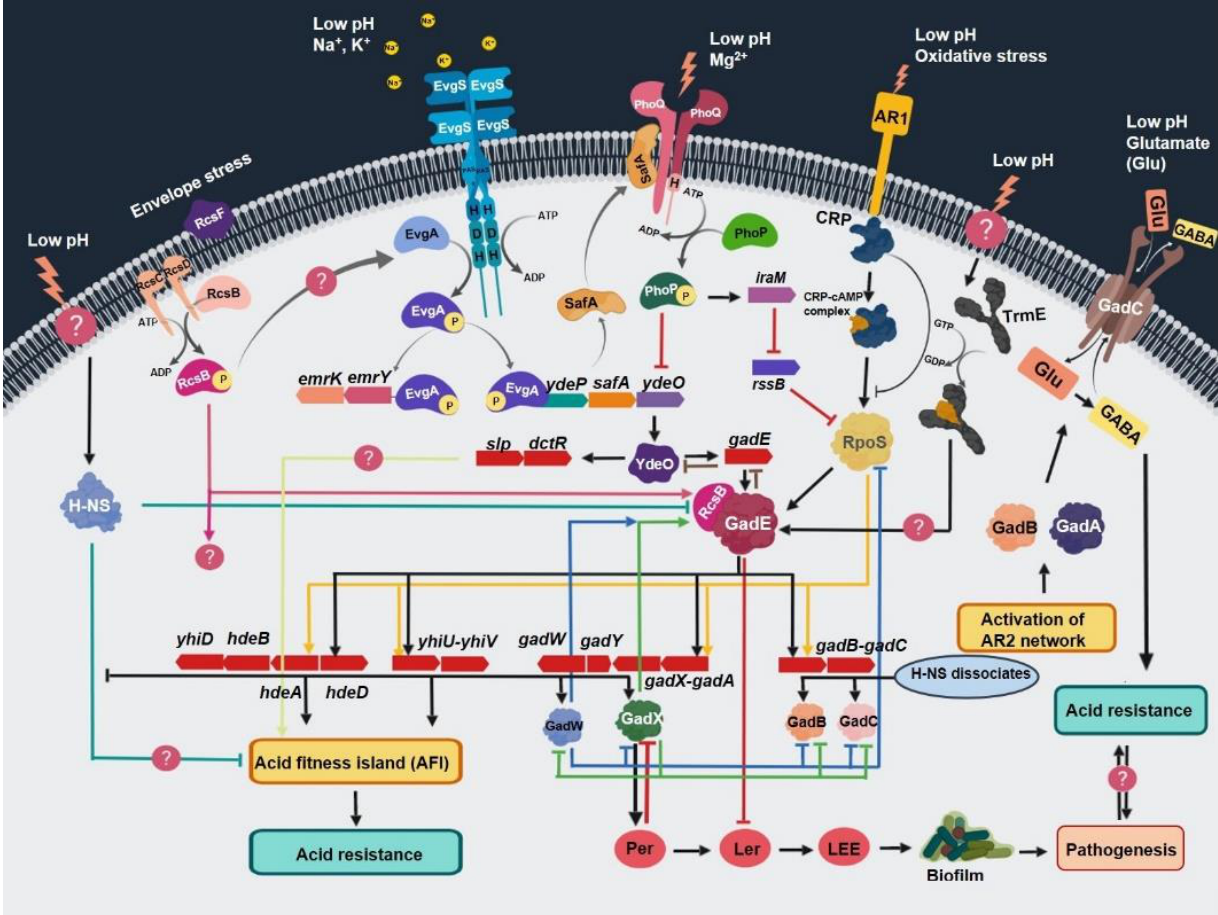
Figure 2. Schematic representation of acid stress regulation by different two-component signal transduction systems, acid-resistance networks, and their interconnecting assemblies. All abbreviations are defined at the end of the manuscript.